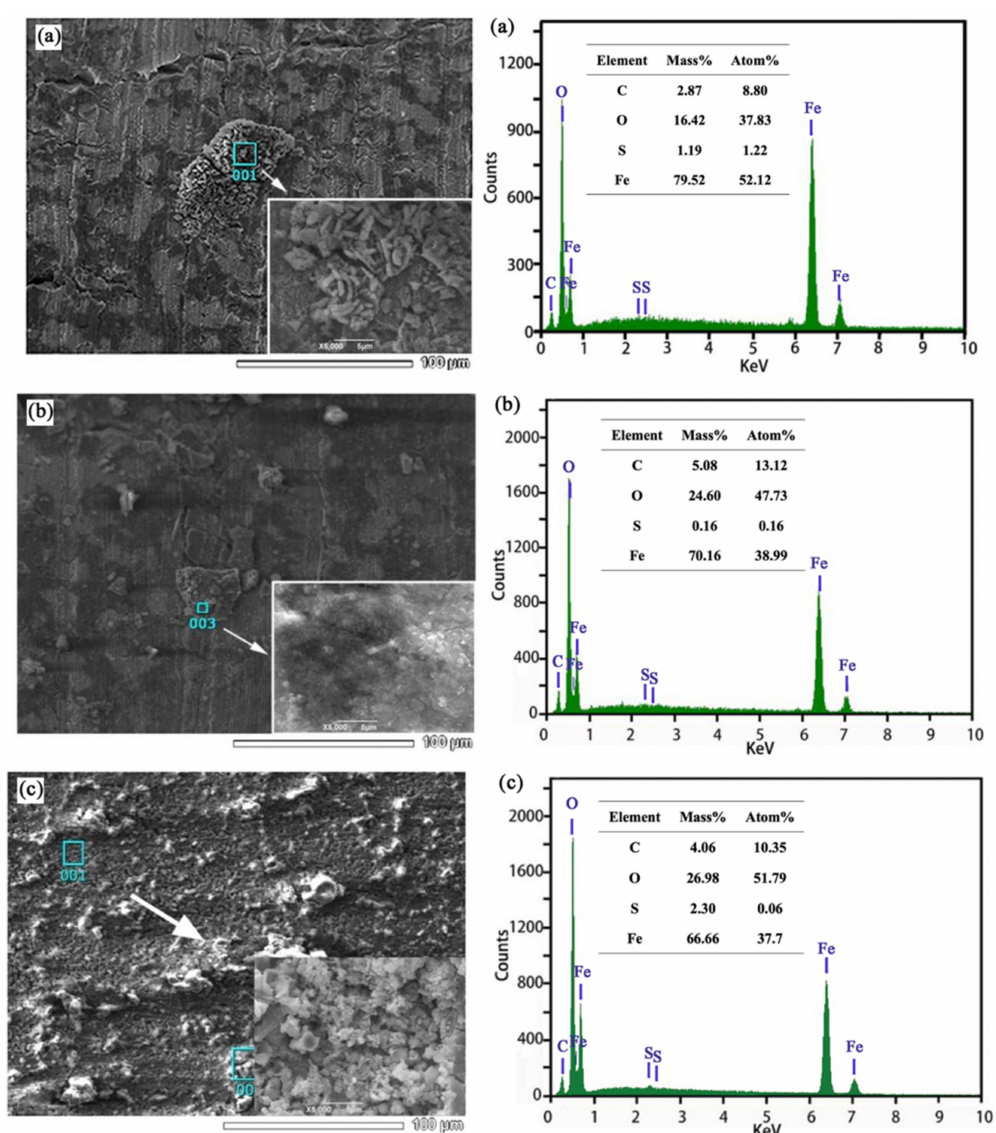
Figure 5. SEM morphology and EDS analysis of X80 steel immersed in SRB environment for 3 days: ( a ) at − 850 mV; ( b ) at − 1000 mV; ( c ) at − 1200